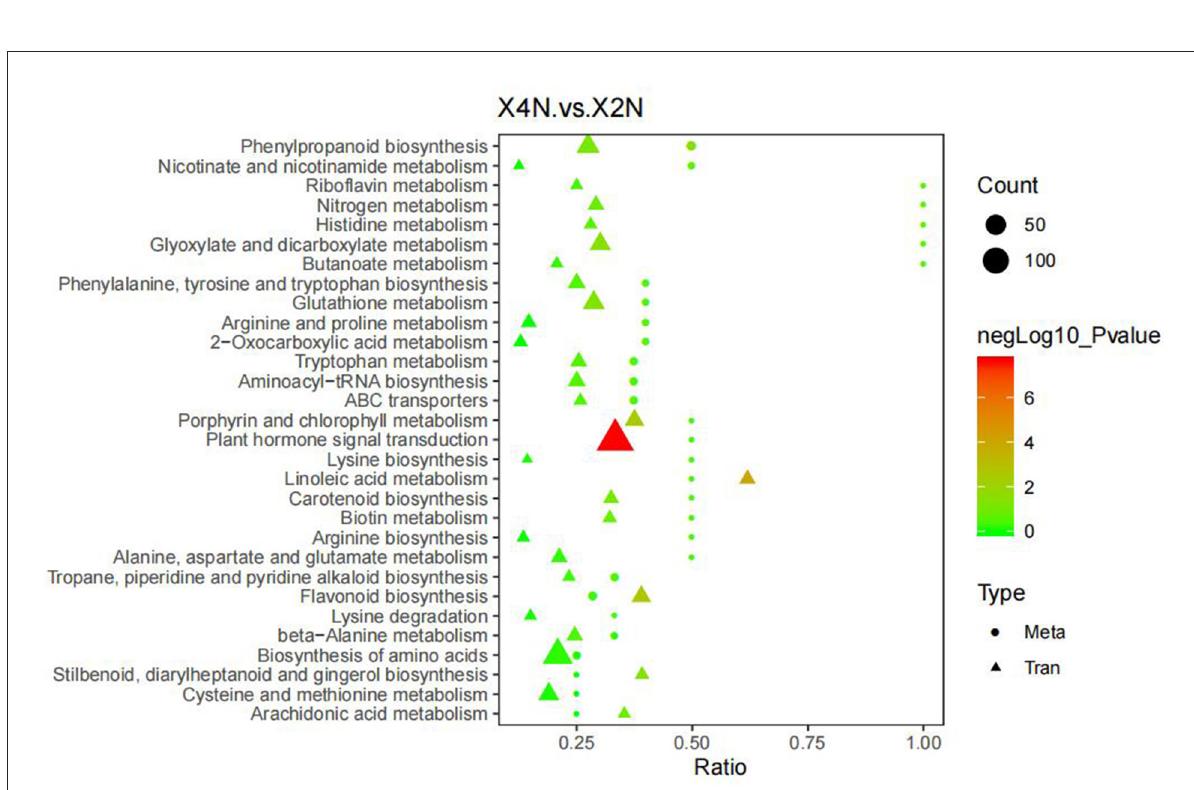
FIGURE10 Association analysis of differential expression genes and differential metabolites. The abscissa represented the ratio of the metabolites or genes enriched in this pathway to the number of metabolites or genes annotated in this pathway, the ordinate represented the KEGG pathway enriched by metabolome and transcriptome. Count represented the number of metabolites or genes enriched in the pathway. X2N, diploids of Pisang Berlin; X4N, autotetraploid of Pisang